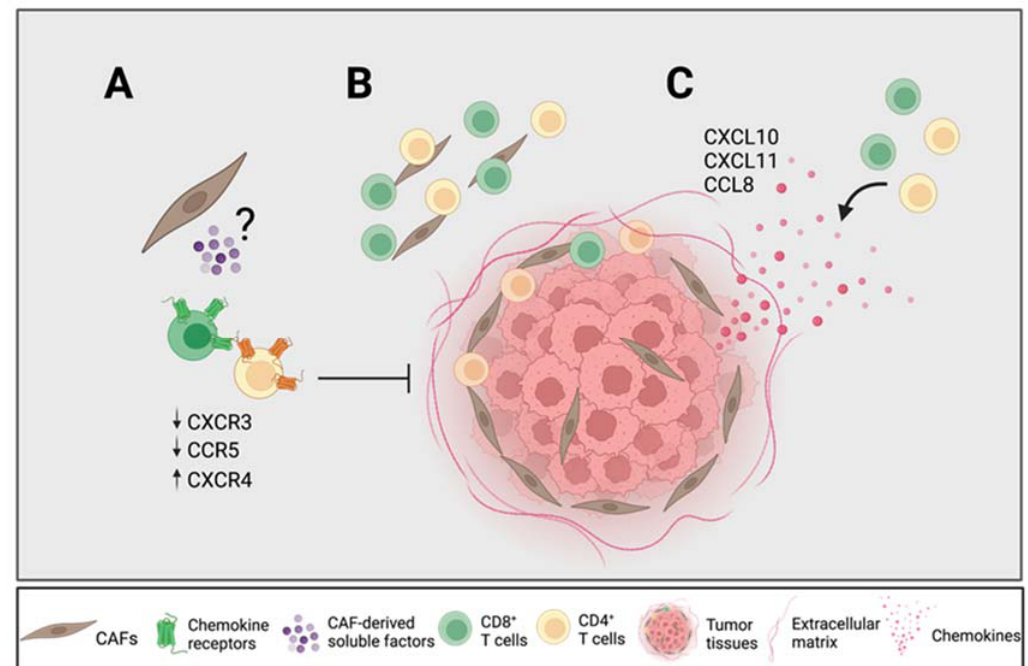
Figure 6. CAFs modulate chemokine receptor expression, which can potentially promote T cell exclusion. ( A ) CAF-derived soluble factors downregulate the chemokine receptors CXCR3 and CCR5 on T cells known to be important for T cell trafficking towards tumor nests and upregulate CXCR4 known to be involved in T cell exclusion. ( B ) CD4 + T cells are equally distributed throughout the stroma whereas CD8 + T cells are found more distantly from the tumor nests. ( C ) High levels of CXCL10, CXCL11 and CCL8 from tumor tissues are associated with a higher CD4 + and CD8 + T cell